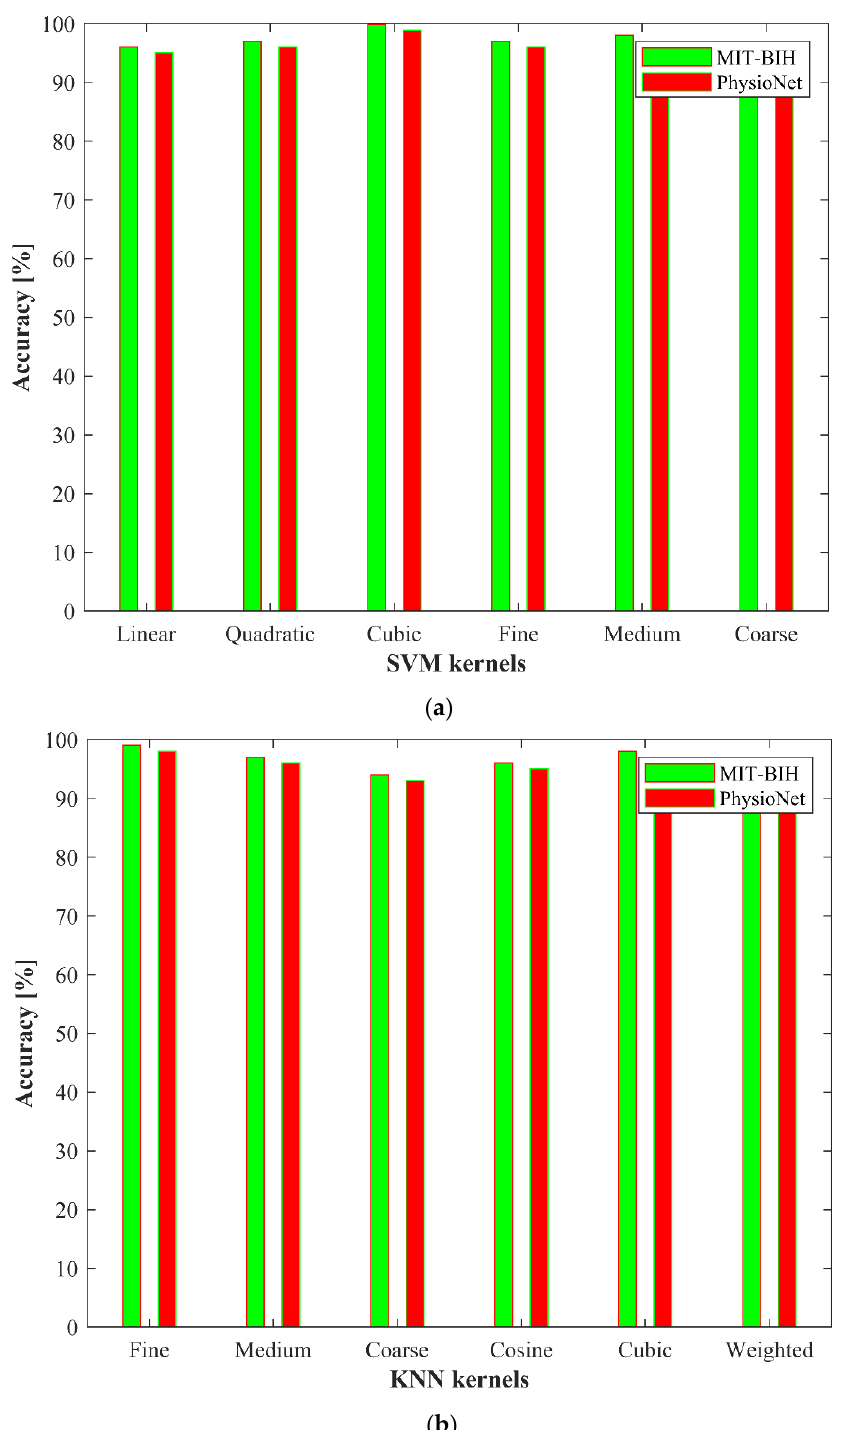
Figure 7. Performance of the different kernels of both classifiers on MIT-BIH and PhysioNet datasets: ( a ) SVM classifier; ( b ) kNN classifier.